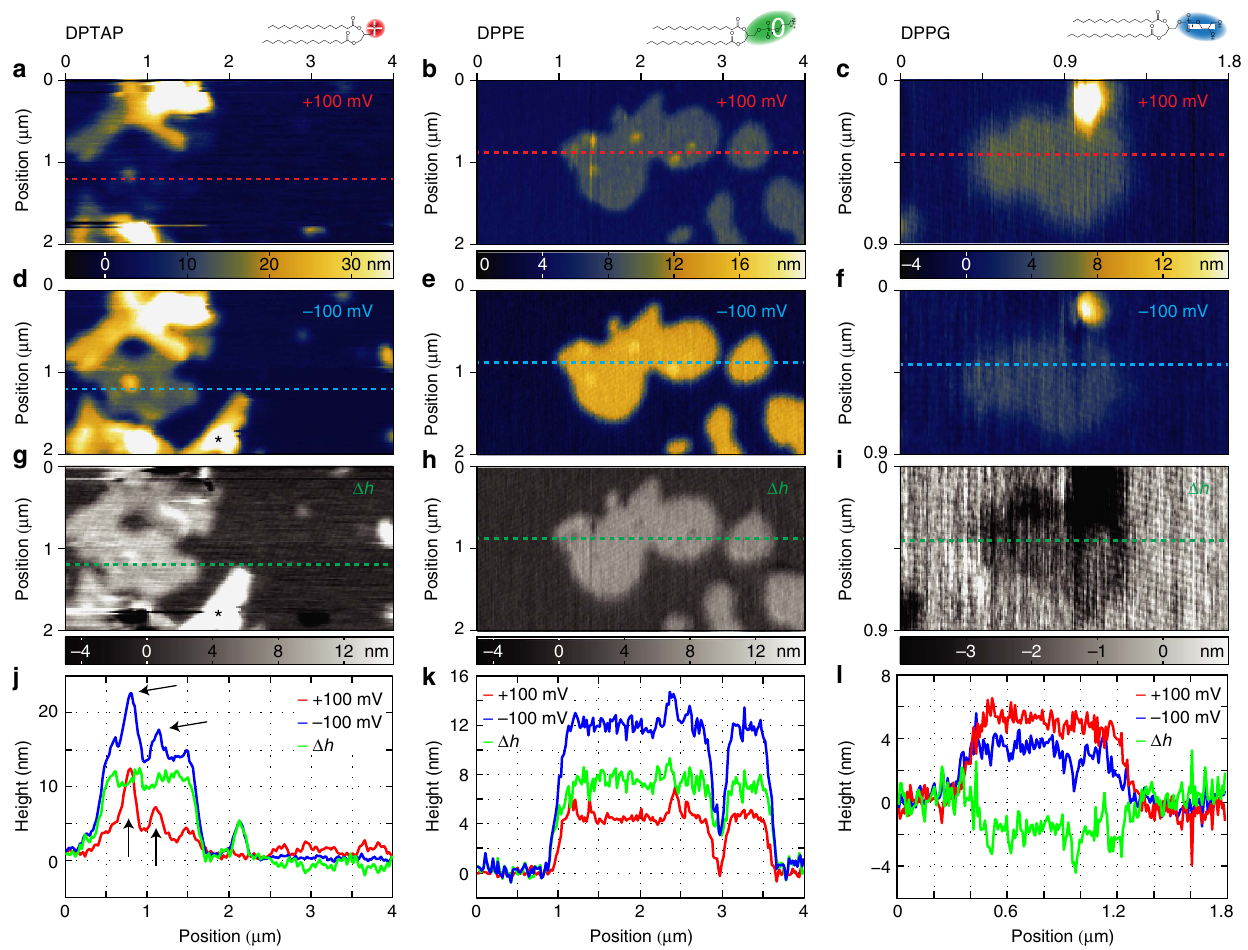
Figure 2 | CIHD measurements of phospholipids. SICM images of DPTAP, DPPE and DPPG scanned at bias potentials of first þ 100mV ( a – c ) and then (cid:2) 100mV ( d – f ). All scans show apparent heights of the lipids that differ from the 5nm physical height measured by AFM. For DPTAP and DPPE the þ 100mV topographies are compressed, while for DPPG it remains somewhat unchanged. At (cid:2) 100mV the topographies of DPTAP and DPPE are stretched by 8.5 and 7nm, respectively, while the DPPG topography is compressed by 2.5nm. ( g – i ) The difference D h between the two apparent topographies; multilayer structures in the lipids vanish giving uniform structures. ( j – l ) Line profiles from a – i . Vesicles on top of the bilayer in j , indicated by black arrows, disappear in the D h profile underlining the topography independence of the CIHD images. During the imaging of DPTAP, a vesicle (*) settled down between scan a and d , this was excluded from further analysis. DPTAP and DPPE images are 2 (cid:3) 4 m m 2 with a pixel size of 20nm, DPPG is 0.9 (cid:3) 1.8 m m 2 (pixel size 8nm). The colour scales between the ± 100mV images of each lipid are valid for